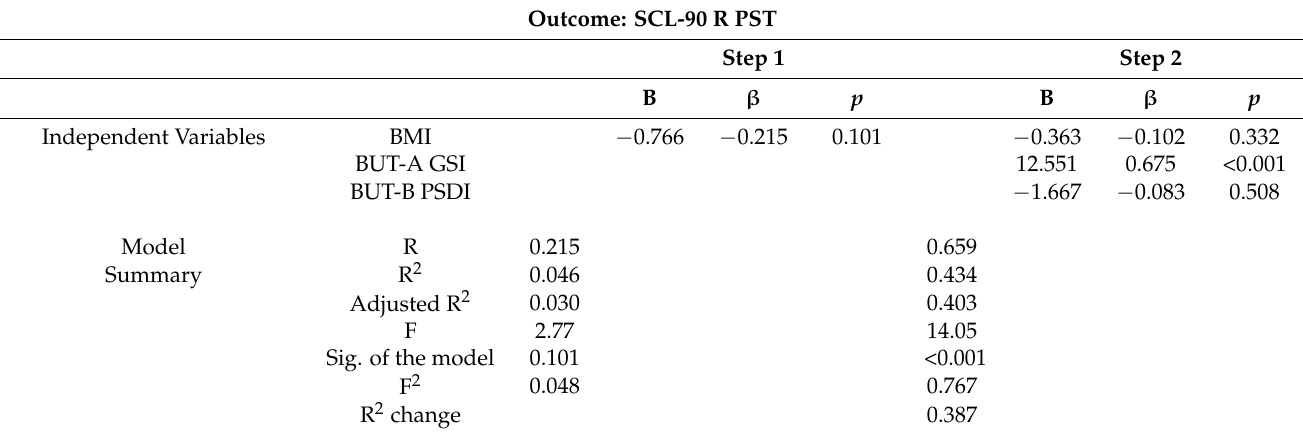
Table 4. Second hierarchical regression models including two steps, with BMI as predictor in first step; BMI, BUT-A GSI, and BUT-B PSDI as predictors of SCL-90 PST in second step. Outcome: SCL-90 R PST Step 1